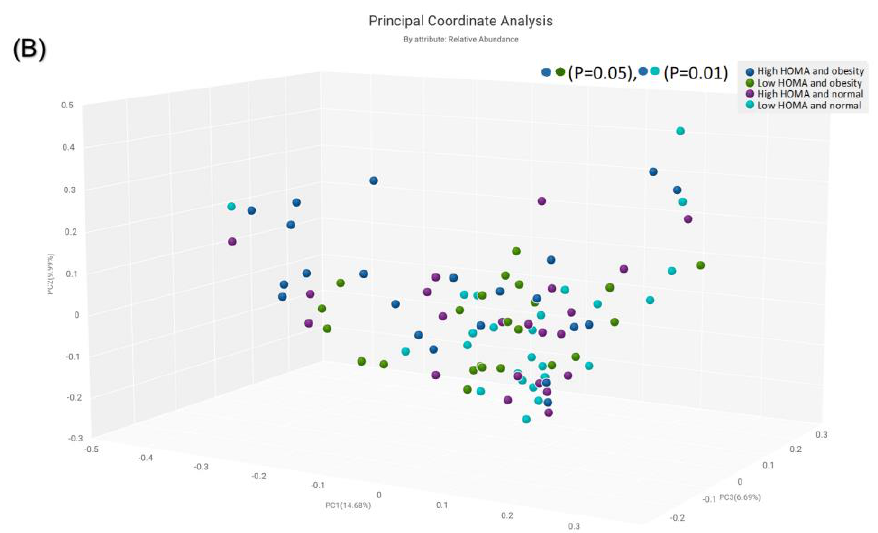
Figure 5. Comparison of bacterial diversities between the gut microbiota of the groups with high HOMA and obesity, low HOMA and obesity, high HOMA and normal weight, and low HOMA and normal weight: ( A ) α -diversity, ( B ) β -diversity.